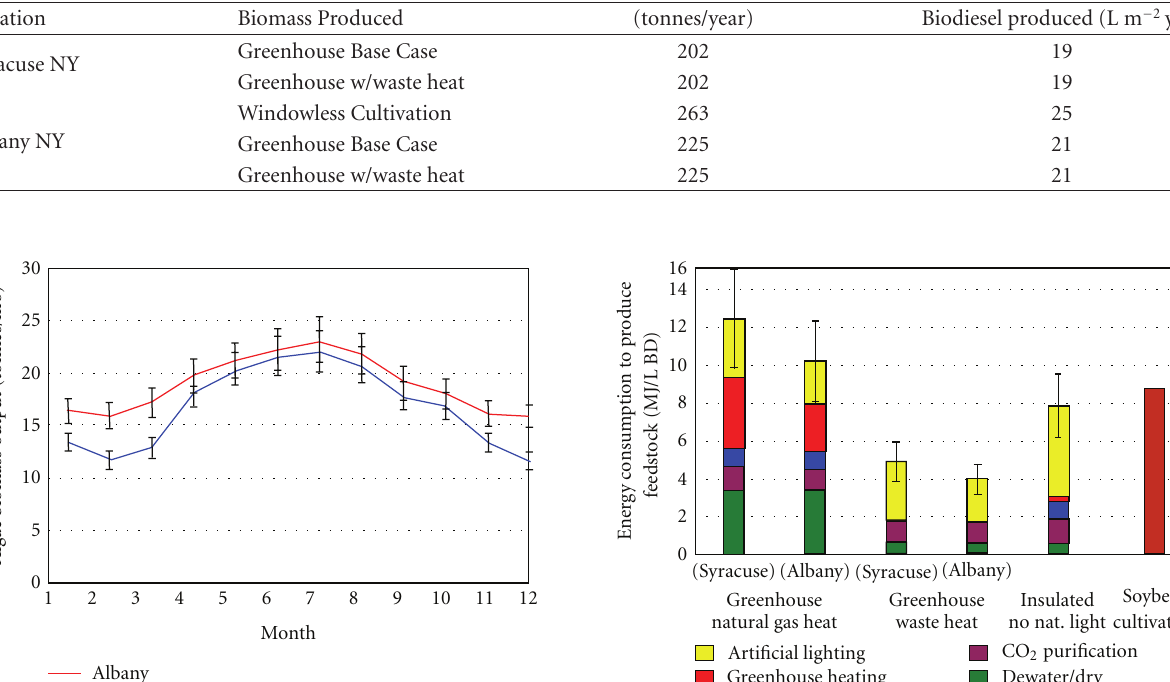
Table 4: Comparison of di ff erent locations and scenarios by biodiesel production.